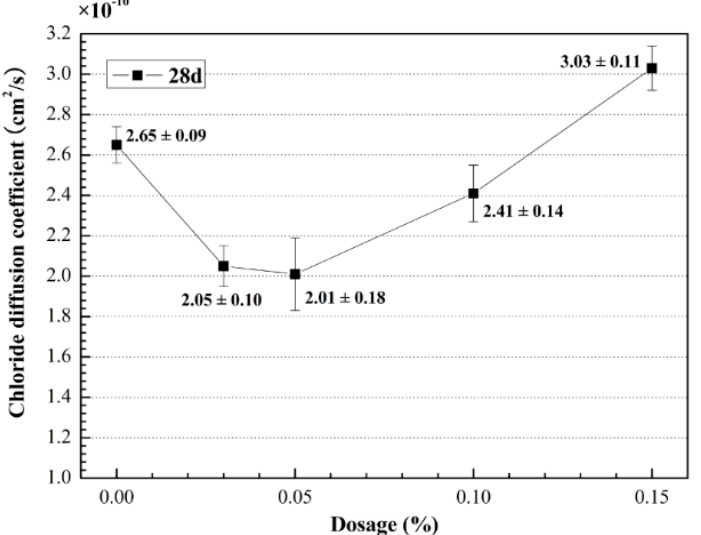
Figure 5. The chloride diffusion coefficient of UHSC with different content of MWCNTs.